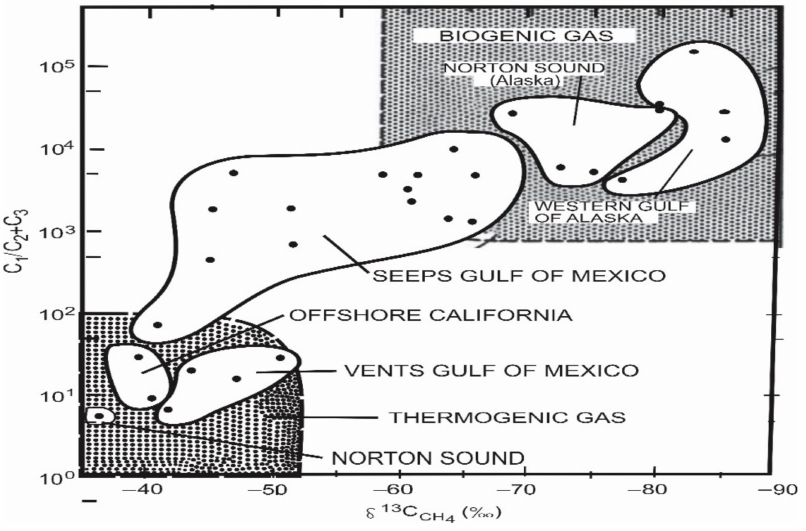
Figure 8. The relationship between carbon isotope values in methane and the C 1 /(C 2 +C 3 ). composi- tional ratios of natural gas samples. (Reproduced from [154] with permission from Elsevier).